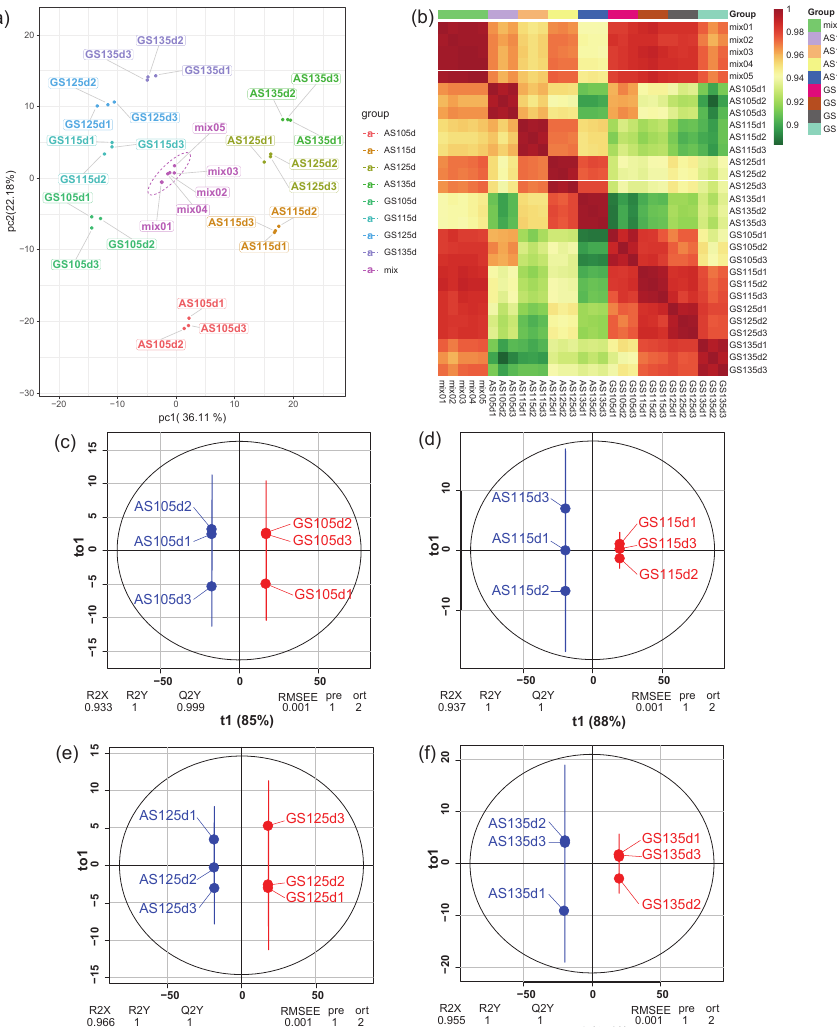
Figure 2. Multivariate statistical analysis for the reliability of samples. ( a ) Principal component analysis (PCA). Samples were grouped by di ff erent colors; ( b ) Pearson correlation estimation. The color in the cell represented the r 2 value which is used to estimate the relationship between two samples. The closer the r 2 value is to 1.00, the more similar the two samples are; ( c – f ) the results of orthogonal partial least squares discriminant analysis (OPLS-DA) at 105d, 115d, 125d, and 135d, respectively. Clear separations between AS and GS were shown in all of the 4